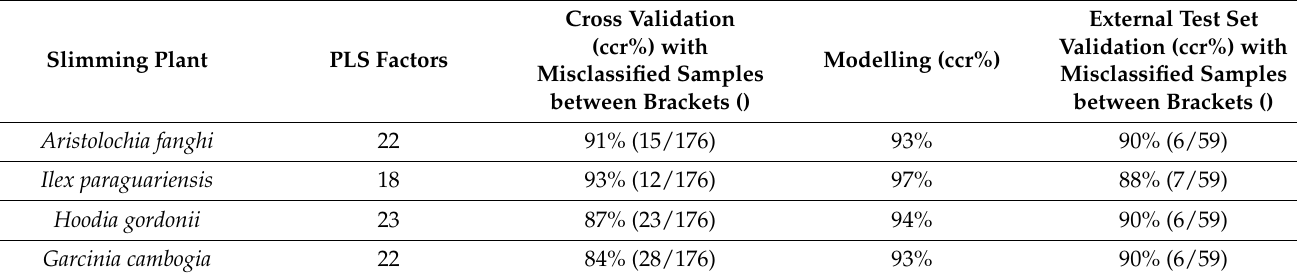
Table 5. Multiclass modelling by PLS-DA depicting the best models selected for each plant. The total data set consisted of 235